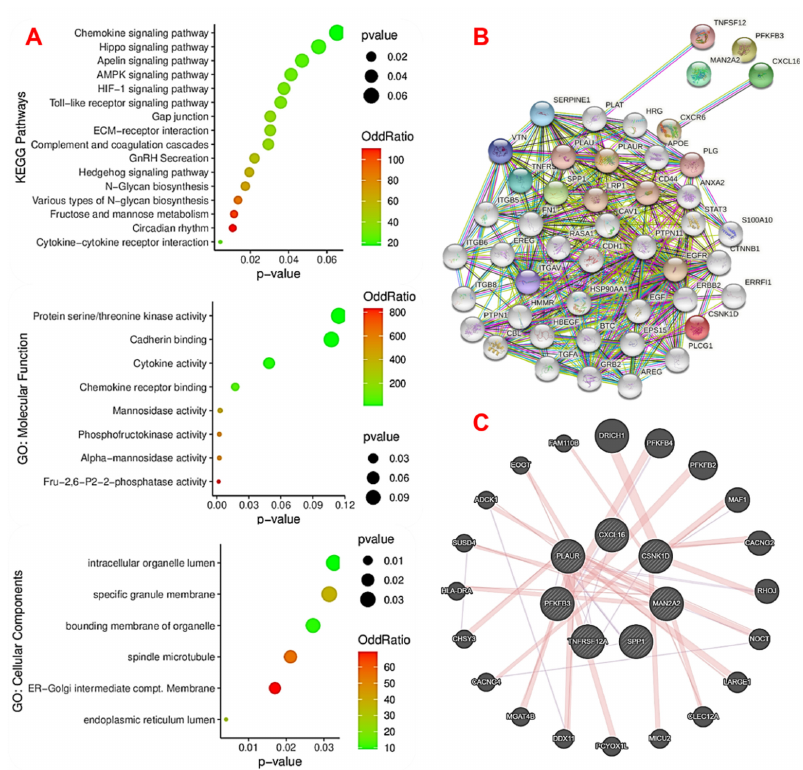
Figure 4. Functional enrichment analysis and biological network analysis of the MTSCPPC signature. ( A ) Visualization of enriched terms in KEGG pathways, and molecular function and cellular component categories in the GO analysis. The color intensity and the size of the round circles indicate, respectively, the odds ratios and p -values of enrichment. All terms were only considered to be significantly enriched at p < 0.05. Visualization of the significant ( B ) protein–protein interaction (PPI) and ( C ) gene–gene interaction (GGI) network clusters of the DEGs.